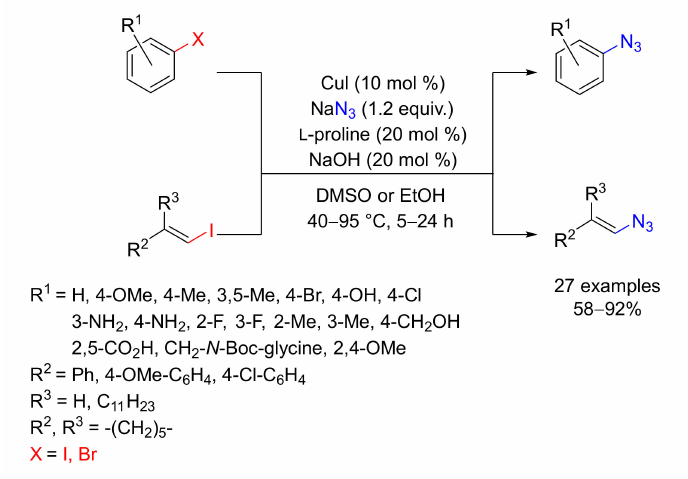
Scheme 11. Copper catalyzed coupling between NaN 3 and aryl